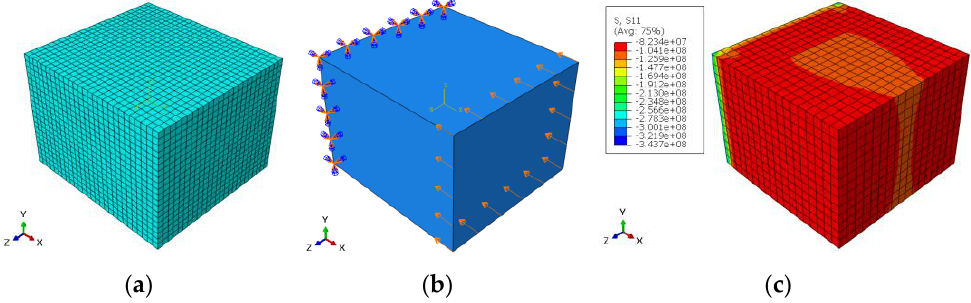
Figure 7. ( a ) FE model, ( b ) boundary conditions and ( c ) stress distribution for radial direction. For the axial direction, the dimensions of the selected sample in the three directions were: 8.4 × 13.48 × 6.73 mm when the experimental fracture stress was 160.97 MPa (see Table 3). The mesh model contained 12,138 elements when the element type was C3D20R (20-node quadratic brick). The number of nodes was: 53,644. The convergence study for element numbers gives less than 1% with element size = 0.0004 m. For the boundary conditions, the displacement in y-direction was: 0.0004605 m in compression and the lower surface in x–z plane was prevented from movement and rotation in x, y and z directions.